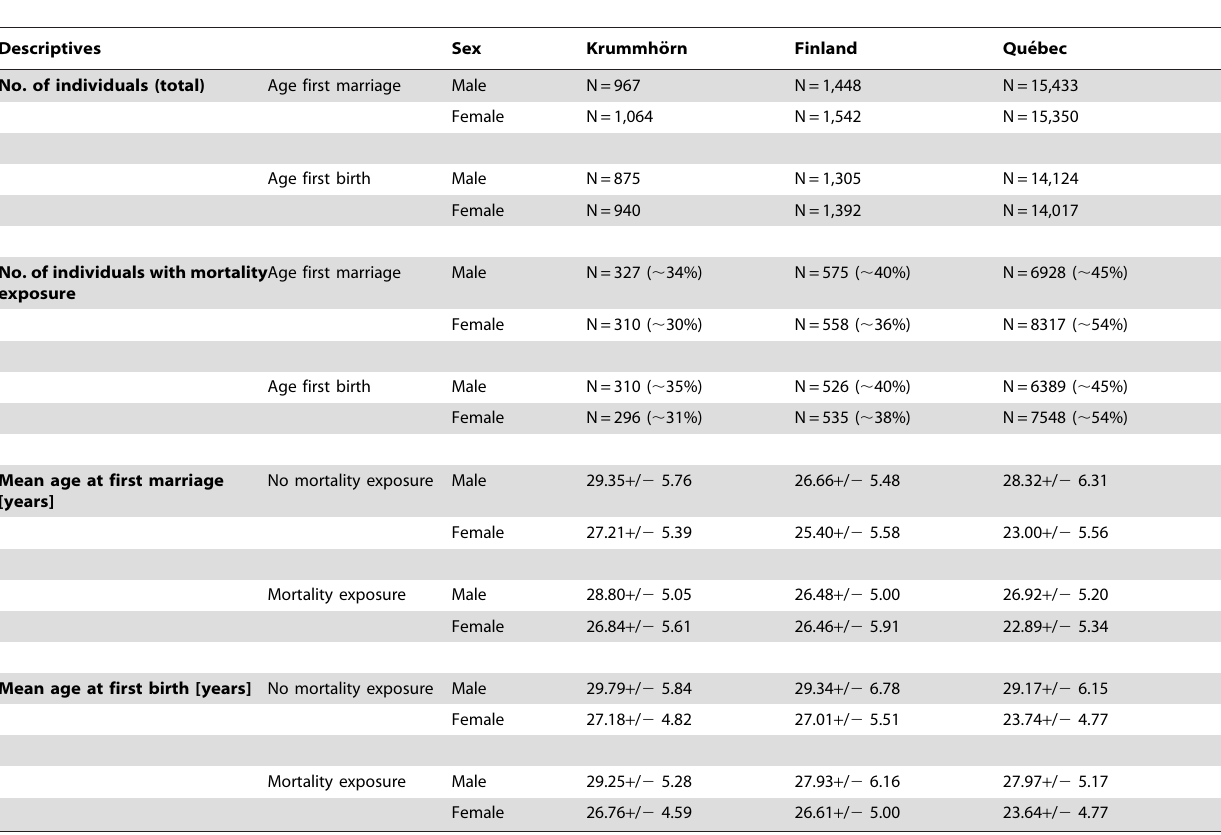
Table 1. Descriptives for the study populations (Krummho¨rn, Finland and Que´bec) including sample sizes, mean ages at marriage and first birth as well as proportions of individuals confronted with mortality separated by